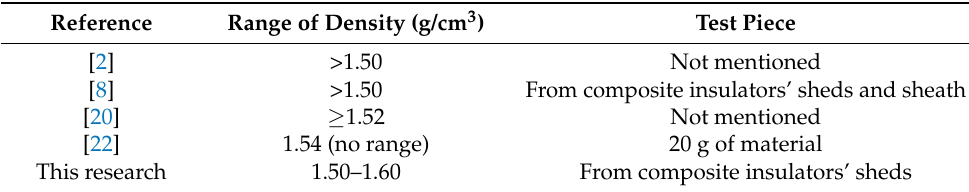
Table 6. Comparative study and contribution to density range of on new (unused) HTV silicone rubber with ATH filler used as composite insulators’ housing material and the corresponding insulators’ regions from which the test pieces were extracted.